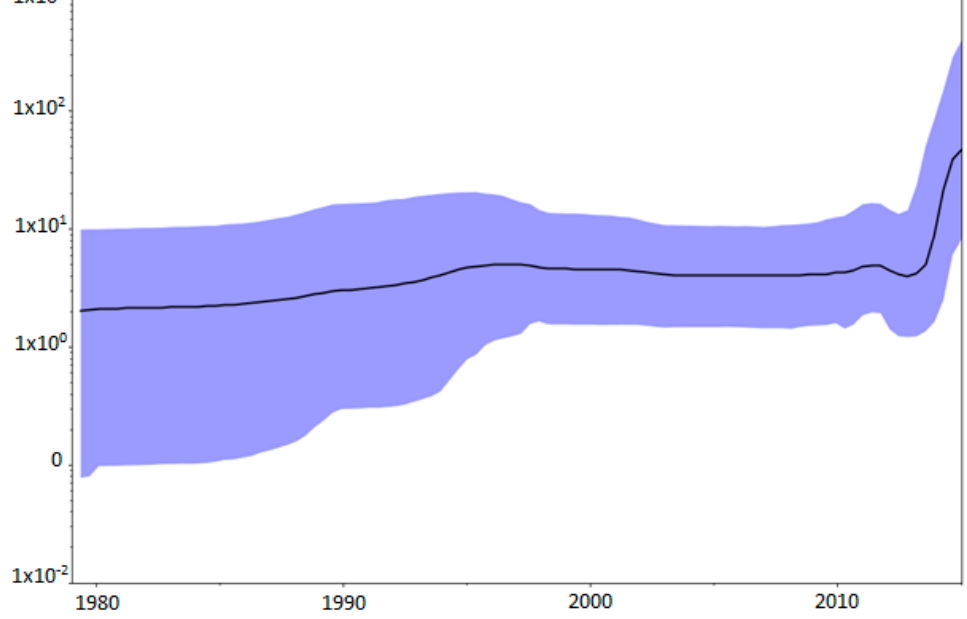
Figure 3. Population dynamics of the CTV-NC genotype. The demographic history of the genotype is shown since its origin in 1977 until the most recent sequence of the dataset, 2015. The Bayesian Skyline plot shows the evolution in population size. Median (dark line) and upper and lower 95% HPD (blue region) estimates of effective population size ( y -axis) through time in years ( x -axis) are